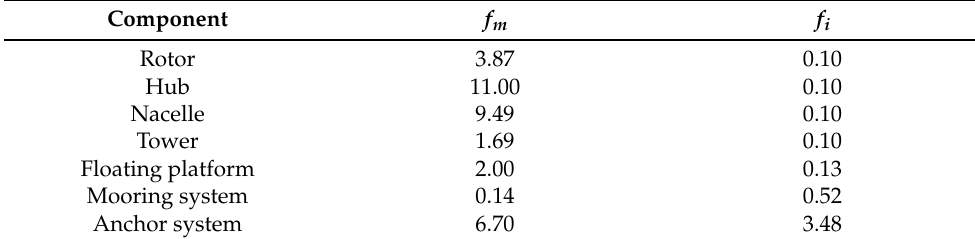
Table 12. Metric space manufacturing and installation